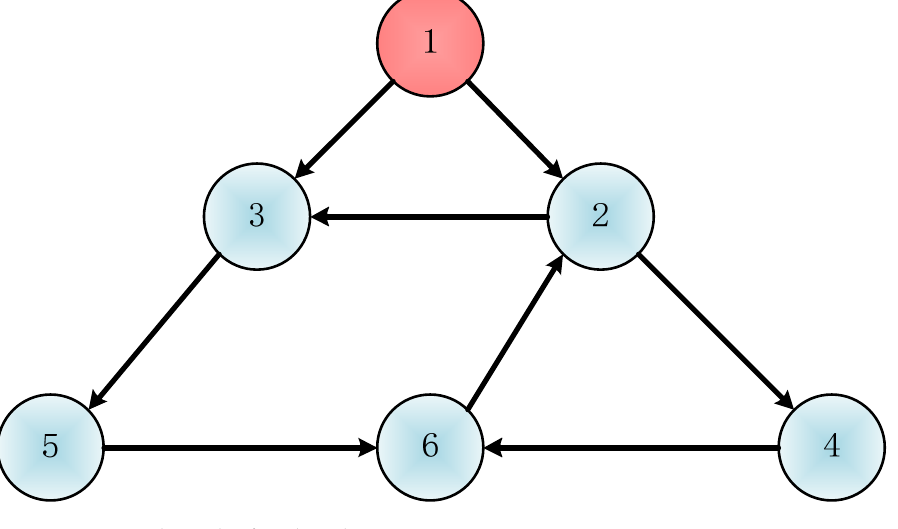
Figure 3. Directed graph of multi-robot system. In Figure 3, the red circle represents the leader robot. The blue circle represents the following robot. The number represents the serial number of the robot. The